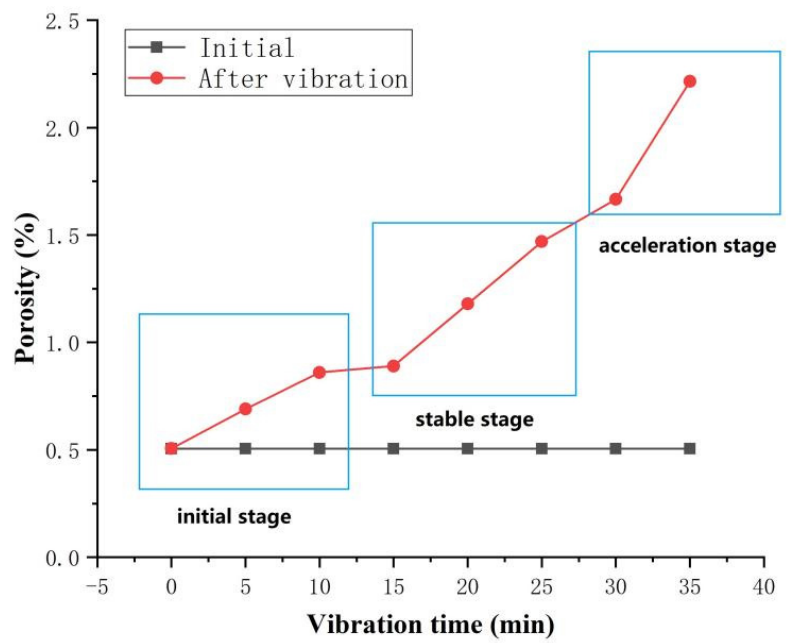
Figure 5. Variation curve of rock sample porosity caused by different vibration times.